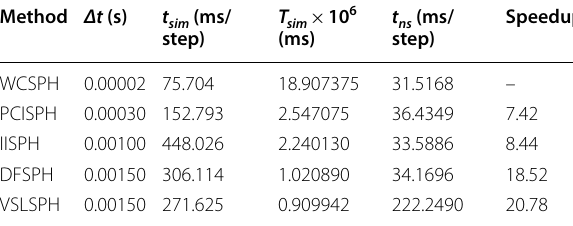
Table 1 Comparison of the simulation